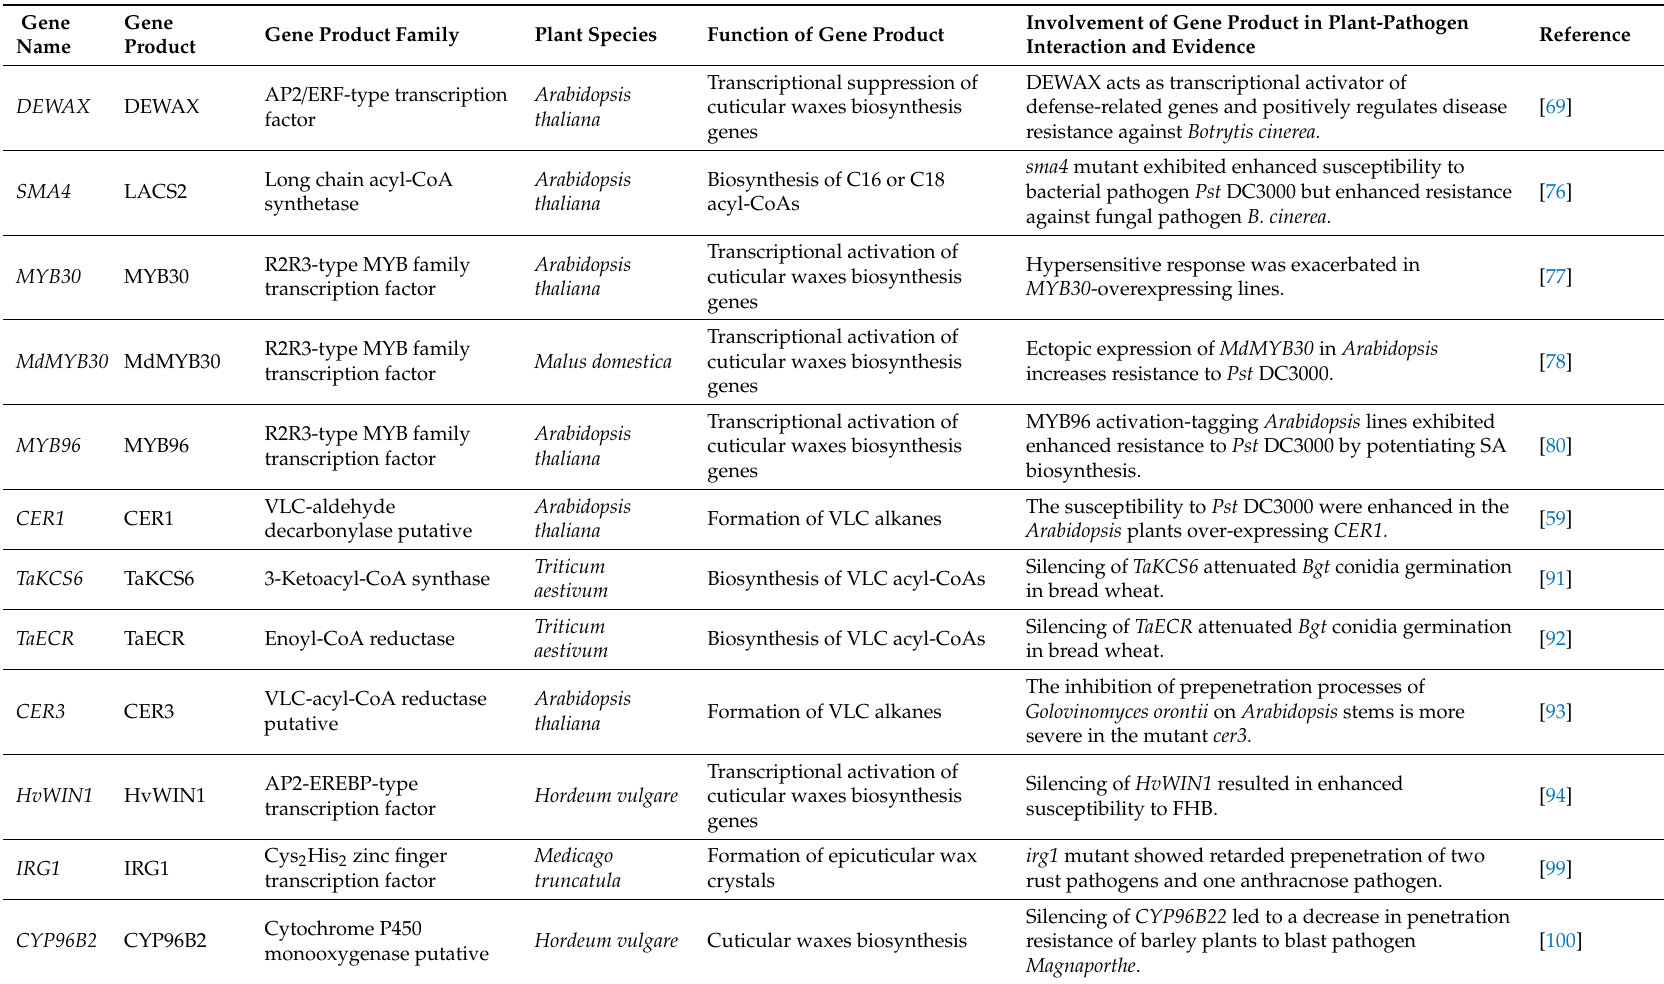
Table 1. Cuticular wax biosynthesis genes involved in plant-pathogen